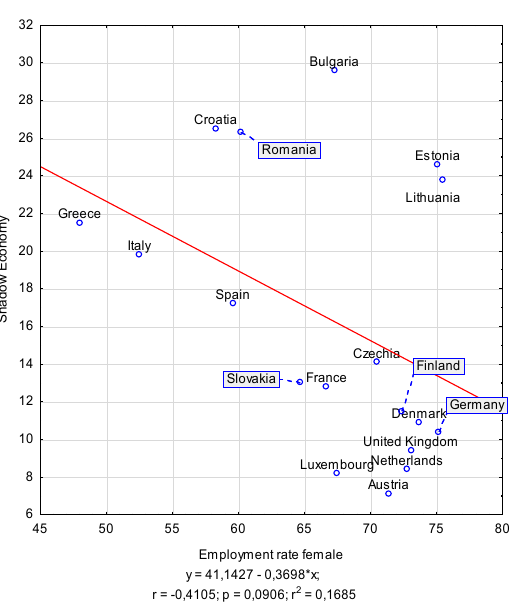
Figure 3. Regression model for shadow economy in terms of unemployment rate for women in the selected European Union countries